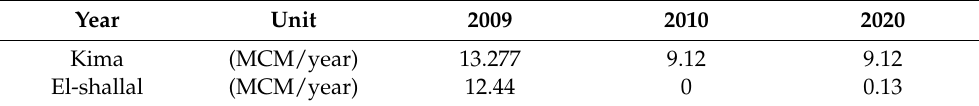
Table 1. Groundwater withdrawal rates from the areas of Kima and El-Shallal.